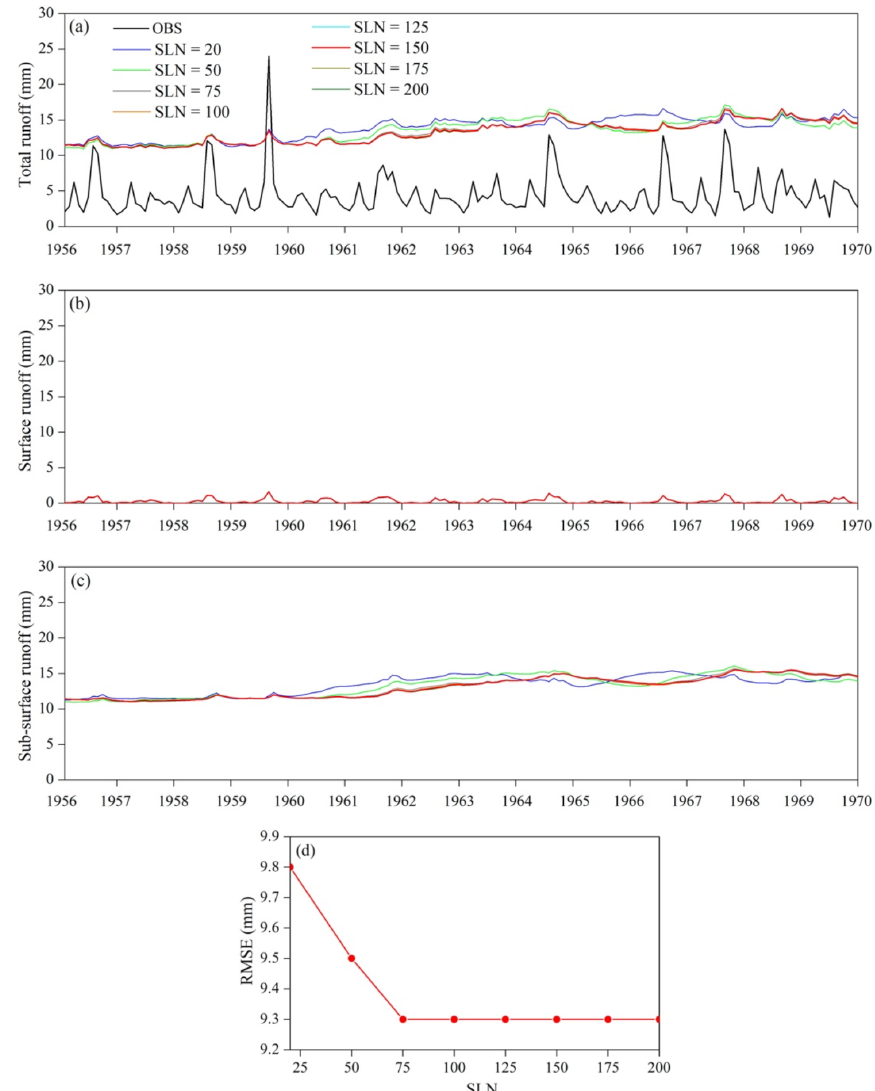
Figure 4. (a) Observed and simulated monthly runoff for the BJC hydrological station; (b) simulated surface runoff; (c) simulated subsurface runoff; (d) RMSEs of the simulated total runoff. All simulations were produced with different SLN values.